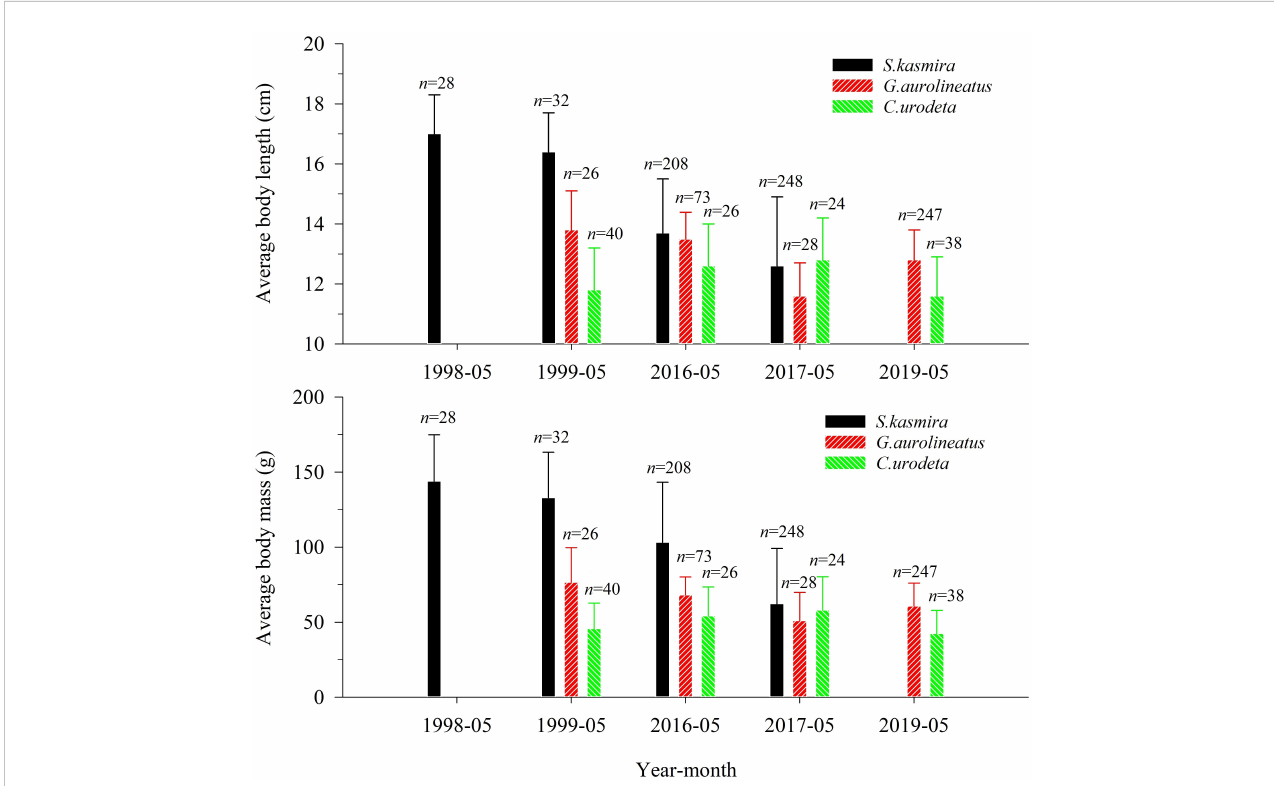
FIGURE 2 Average body length and average body mass of Lutjanus kasmira , Gnathodentex aureolineatus and Cephalopholis urodeta during 1998 – 2019 in the Yongshu Reef, South China Sea. The error bars represents the corresponding standard deviation. The n above the error bar represents the number of corresponding replicate